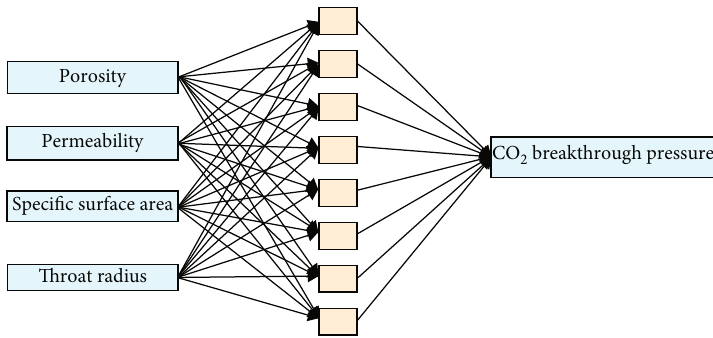
Figure 11: Topological structure of the BP neural